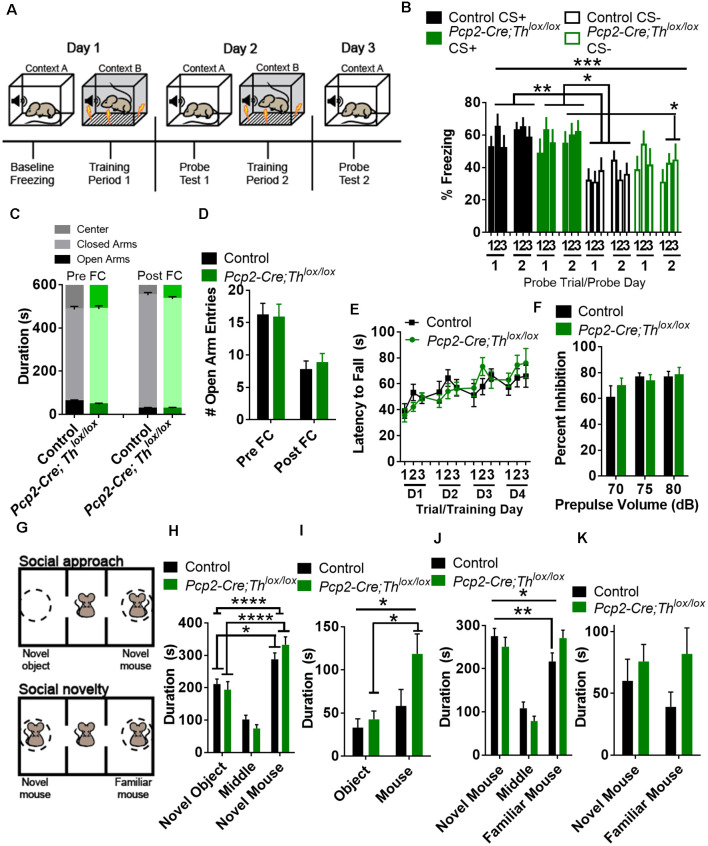
Conditional knockout of Th in all Purkinje cell fibers results in altered fear conditioning and social recognition memory, but not anxiety, sensorimotor gating, or gross motor deficits. (A) Schematic for fear conditioning experiment. (B) Freezing after fear conditioning of Pcp2-Cre;Thlox/lox mice (Green, n = 10) and littermate controls (Black, n = 18) on a fear discrimination task with a low-amplitude shock (0.3 mA) in both groups showed an increased association of CS+ to shock on the probe. There was an effect of genotype, F(3,52) = 6.59, p = 0.0007, but not an effect of training F(5,260) = 1.37, p = 0.236, or an effect of interaction between genotype and training F(15,260) = 0.96, p = 0.498, Two-way rmANOVA. On post hoc analyses (Tukey’s multiple comparisons test) Control mice discriminated between CS+ and CS− over the entire period (**p < 0.01), while Pcp2-Cre;Thlox/lox mice did not. Both groups discriminated between CS+ and CS− after 2 days of conditioning, *p < 0.05. Error bars are SEM. (C) Time spent in the center area, open and closed arms before (Pre FC), and after (Post FC) fear conditioning. Pcp2-Cre;Thlox/lox mice (Green, n = 10) and littermate controls (Black, n = 18) mice showed no differences in time spent in any region before or after fear conditioning. Error bars are SEM. (D) Number of entries into open arms before (Pre FC) and after (Post FC) fear conditioning. Pcp2-Cre;Thlox/lox mice (Green, n = 10) and littermate controls (Black, n = 18) mice showed no differences in time spent in open arms before or after fear conditioning. Error bars are SEM. (E) Performance of control (black, n = 9) and Pcp2-Cre;Thlox/lox mice (green, n = 6) on accelerating rotarod over 4 days of training. No difference observed between groups or the effect of group interaction with training. Error bars are SEM. (F) Prepulse inhibition of the acoustic startle reflex was not significantly different between groups; Pcp2-Cre;Thlox/lox mice (Green, n = 10), controls (Black, n = 10). No difference observed between groups or the effect of interaction between group and prepulse volume. Error bars are SEM. (G) Schematic of social interaction assays. (H) Social approach as measured by time spent in the arena with a novel mouse or novel object. Factor for time spent in zone(F(2,78) = 71.53, p < 0.0001) was significant, but interaction (genotype group × zone, F(2,78) = 2.22, *p = 0.115) and genotype (F(1,78) < 0.0001, p = 0.996) were not. On post hoc analysis, both controls and Pcp2-Cre;Thlox/lox had preferences for novel animal over novel objects (Black, n = 11, *p < 0.05), Pcp2-Cre;Thlox/lox mice (Green, n = 7, ****p < 0.0001), Two-way rmANOVA, Sidak’s multiple comparison’s test. Error bars are SEM. (I) Social approach as measured by time spent in interaction zones with a novel mouse or novel object. Factors for time spent in interaction zone (F(1,16) = 20.63, ***p < 0.001) and interaction (genotype group × zone, F(1,16) = 5.2, *p < 0.05) were significant, but genotype (F(1,16) = 2.79, *p < 0.114) was not. On post hoc analysis, only Pcp2-Cre;Thlox/lox had preferences for novel animal interaction zone over the novel object (Green, n = 7, ***p < 0.001), Two-way rmANOVA, Sidak’s multiple comparison’s tests. Error bars are SEM. (J) Social preference as measured by time spent in the arena with a novel or familiar mouse. Factors for interaction (genotype group × zone, F(2,32) = 3.87, *p < 0.05) and zone (F(2,32) = 25.33, p < 0.0001) were significant, as well as for time spent (preference for novel mouse over a familiar mouse) in control mice (Black, n = 11, **p < 0.01), but not Pcp2-Cre;Thlox/lox mice (Green, n = 7) on post hoc analysis. Two-way rmANOVA, Sidak’s multiple comparison test. Error bars are SEM. (K) Time spent in interaction zones in the social novelty phase of the test. No significant difference in the factors of time, genotype or interaction was found between controls and Pcp2-Cre;Thlox/lox mice in this comparison. Error bars are SEM.